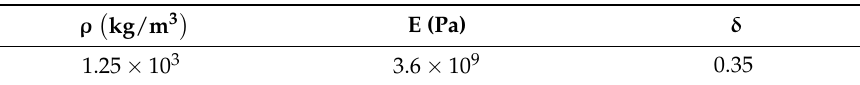
Table 4. The specific values of